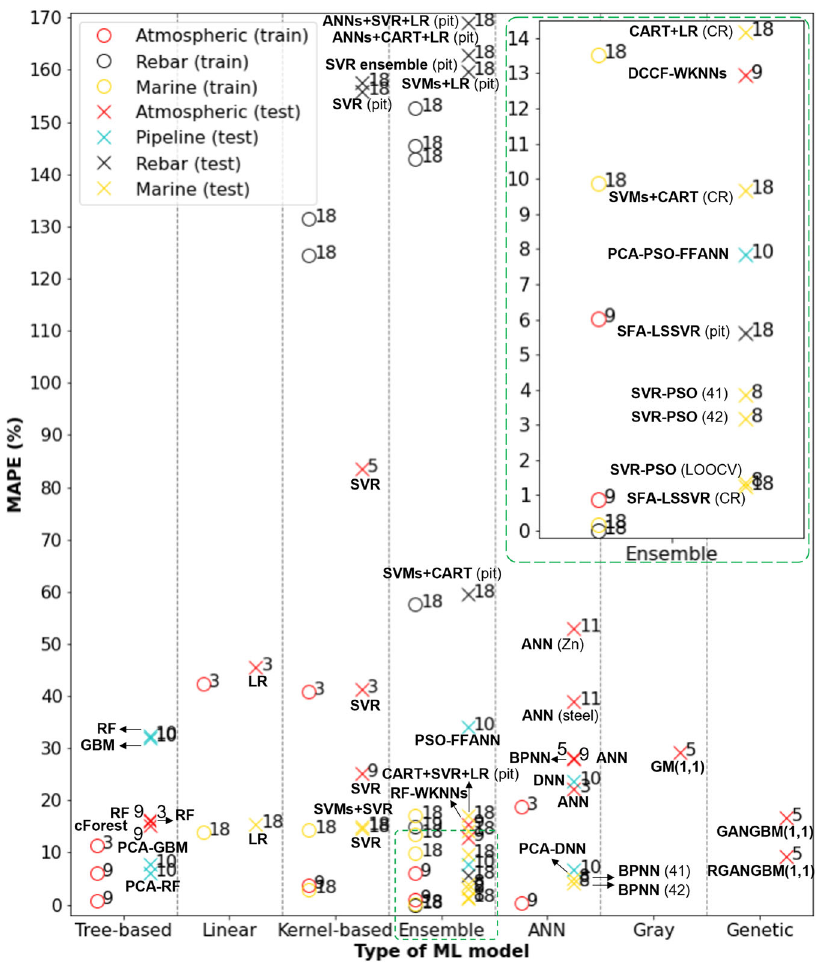
Fig. 6 Performance of the ML models expressed by the MAPE (refs. 3,5,9 – 11,13,18 ), segmented by ‘ Corrosion topic ’ and by ‘ Type of ML model ’ . MAPE values are distinguished for training ( ‘ O ’ ) and testing ( ‘ X ’ ) performances. The models ’ names were included right next to the respective ‘ X ’ points (other useful descriptors were also included whenever possible). Part of the results for the Ensemble models is magni fi ed in the inset image (green